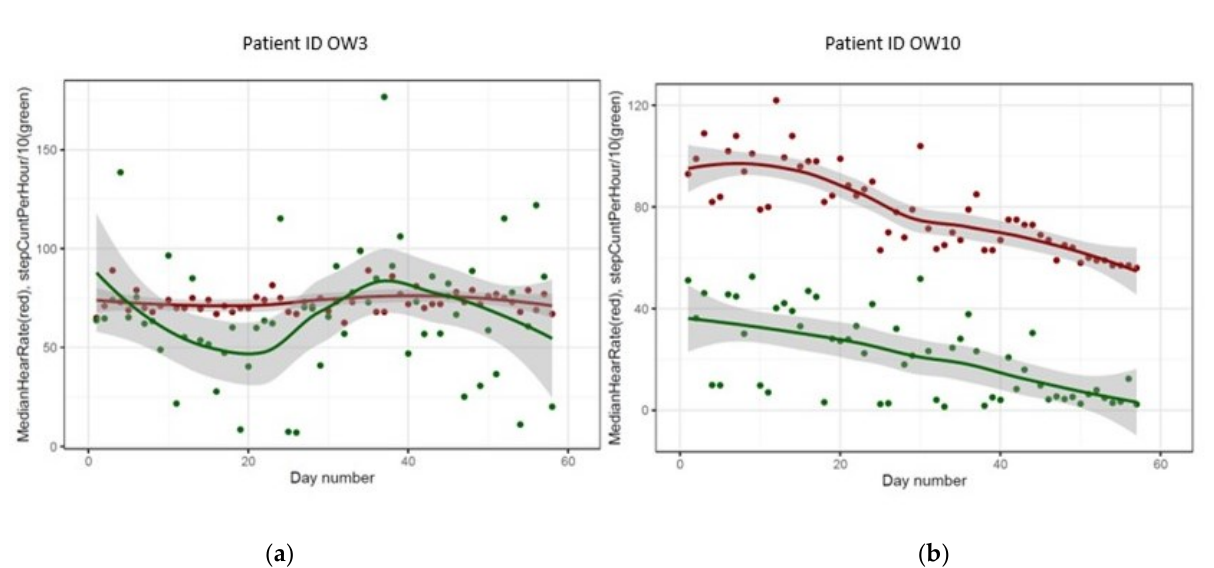
Figure 1. Examples of heart rate and step count variations during the study period: ( a ) patient ID OW3 ; ( b ) patient ID OW10 .